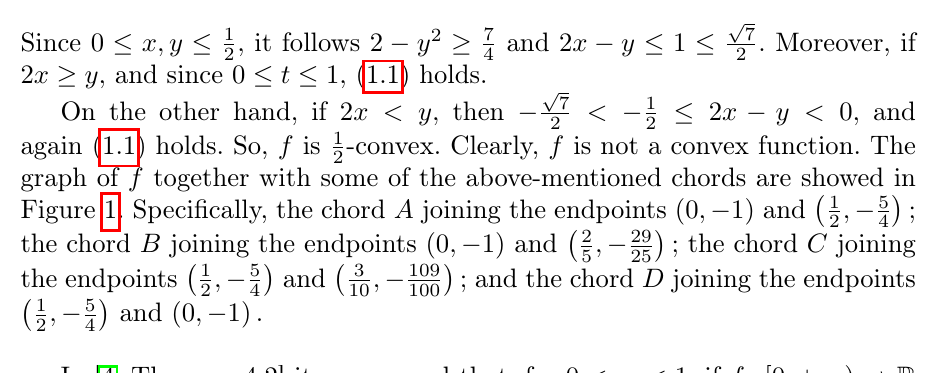
Figure 1. The graph of a function that is m -convex but not